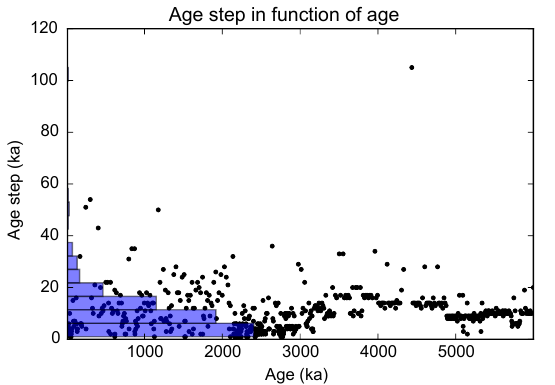
Figure 5. The age step, (t k − t k − 1 ), ∀ k ∈ 2 ,...,N , and its distribu- tion.